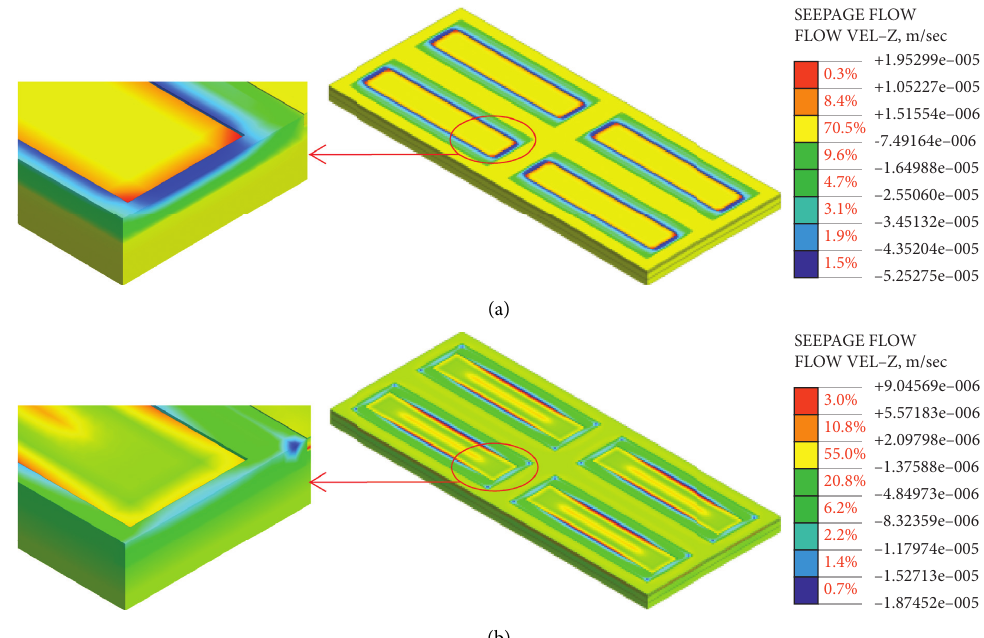
Figure 19: Infiltration velocity nephograms of buildings without seepage wells after (a) 10min and (b) 120 min of rainfall in the numerical model (the color of the legend represents the infiltration velocity range. The value of the legend represents the infiltration velocity value. The red % represents the volume percentage of color legend in the whole numerical model.).